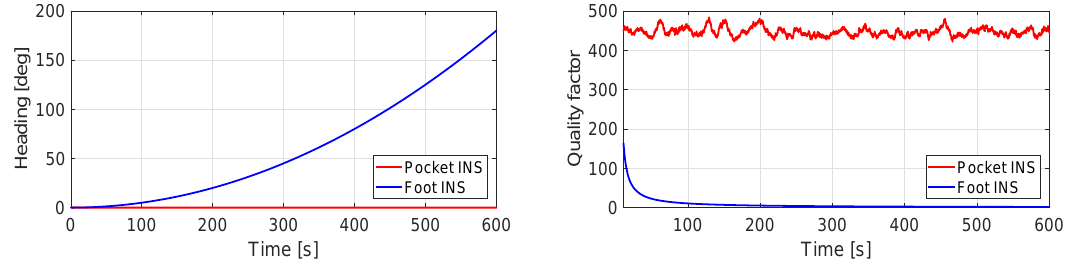
Figure 11. ( Left ) Heading estimation of the pocket INS and the foot INS of a still IMU. The turn rate measurements to the pocket INS have no bias. The turn rate measurements to the foot INS have a changing bias in the z -axis; ( Right ) Quality factor estimation of the heading